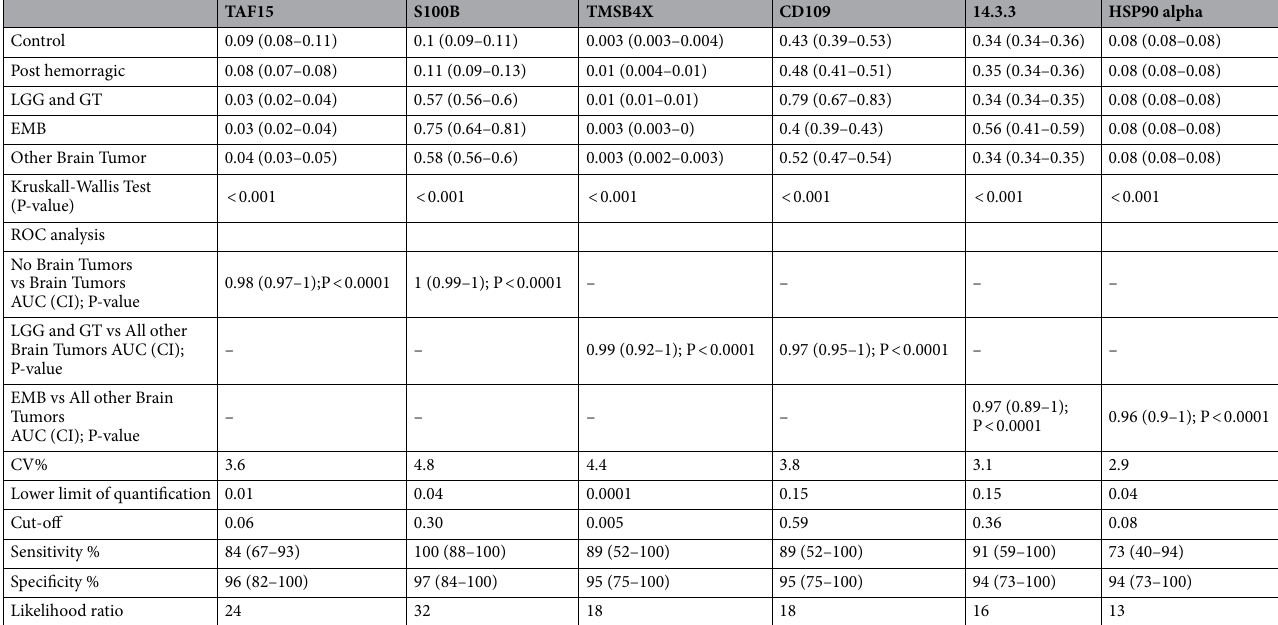
Table 1. ELISA dosage. ELISA dosage was conducted on the core panel of potential biomarkers of cerebrospinal fluid from extraventricular drainage. Their receiver operating characteristic (ROC) curve analysis, for the different comparisons reported in this study was performed. Biomarker dosage is expressed in ng/ml as median and interquartile range. In the ROC analysis AUC, 95% of the confidence interval (CI), P value, cut-off, sensitivity, specificity and likelihood ratio are